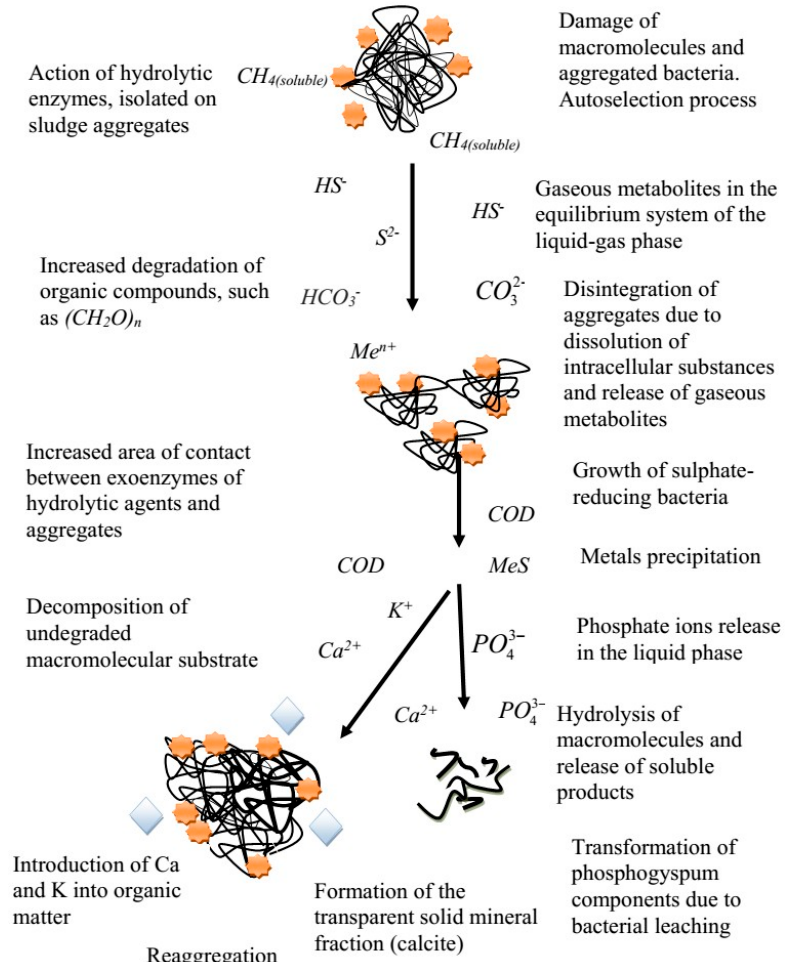
Figure 8. The general scheme of factors involved in the process of anaerobic conversion of sewage sludge and phosphogypsum under sulphate-reducing conditions.